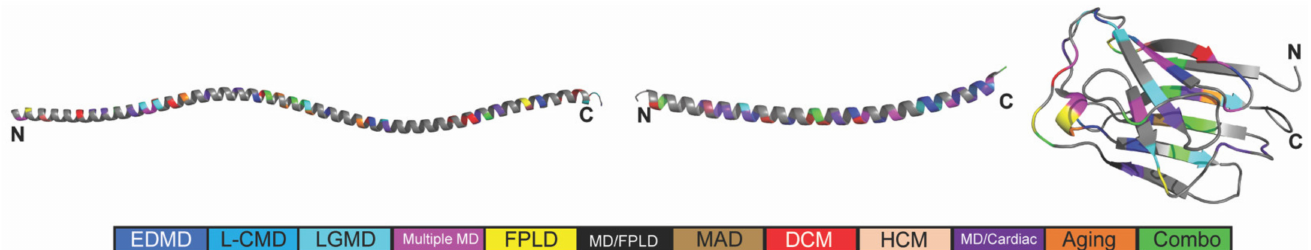
Figure 1. Disease-associated amino acids were in silico mapped onto determined structures for lamin A/C. Previously determined structures of portions of lamin A/C include coil 1B (PDB: 6SNZ, residues 63–222) and coil 2B (PDB: 1X8Y, residues 313–385) of the rod domain, and the Ig-like fold (PDB: 1IVT, residues 428–549). Colored residues indicate the position of amino acid substitutions that cause laminopathies (color code bar